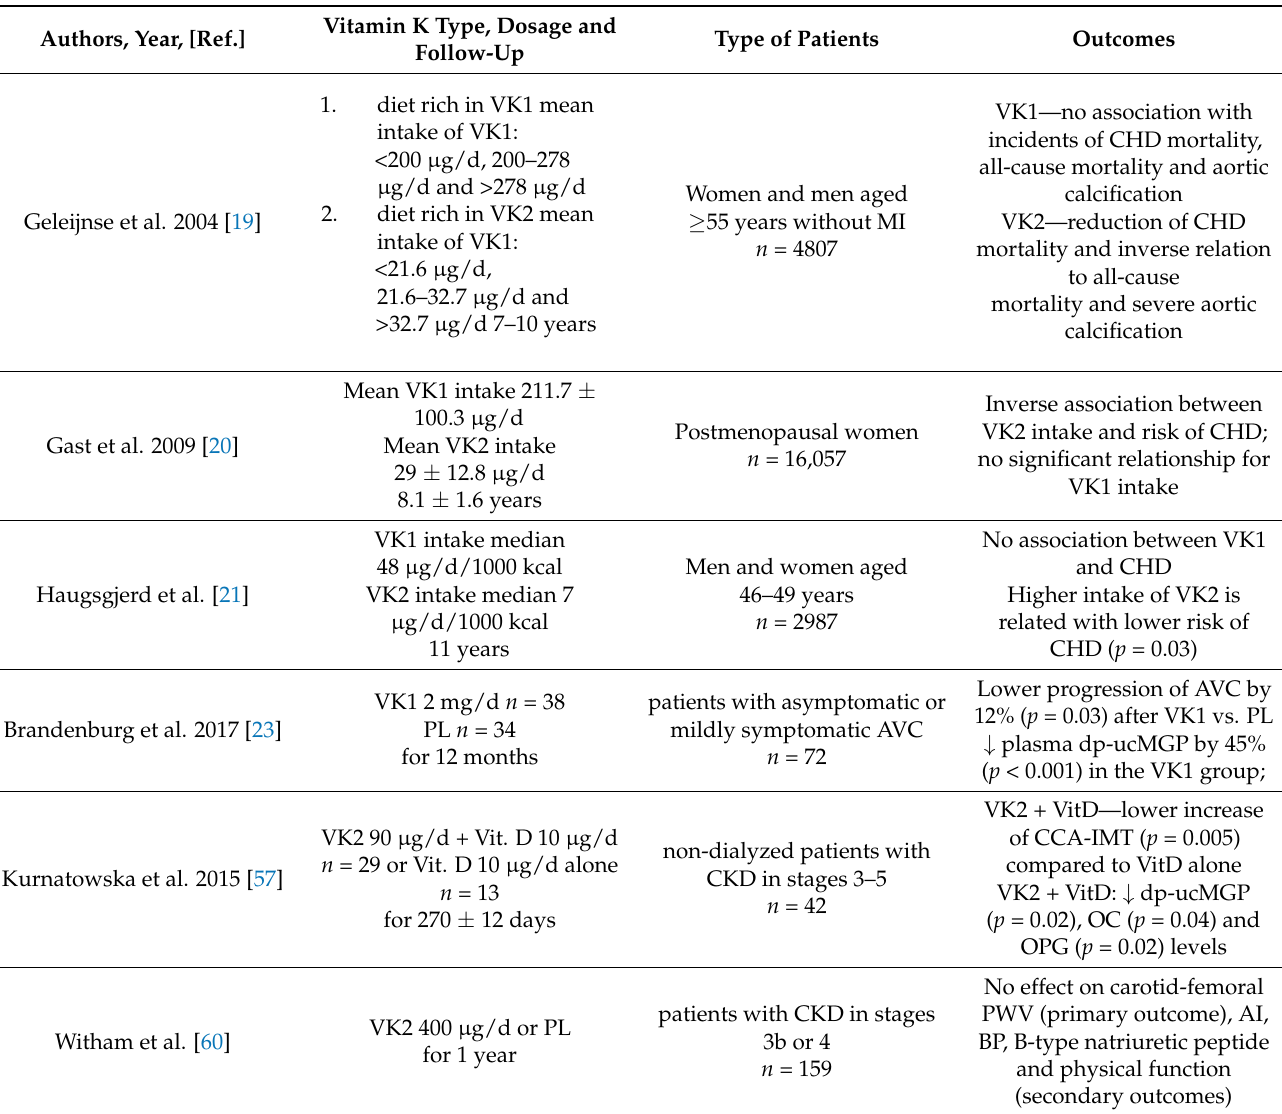
Table 1. Effects of supplementation of vitamin K—clinical